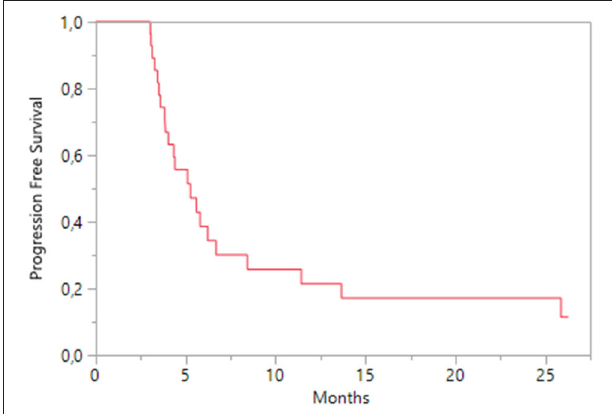
FIGURE 5 | Kaplan-Meier estimates of Progression Free Survival on everolimus